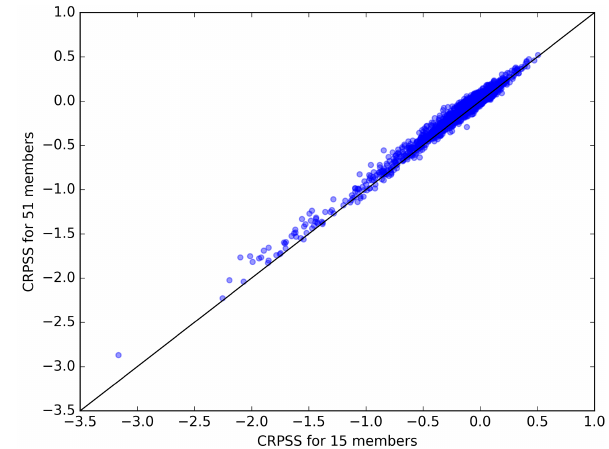
Figure 6. CRPSS calculated for the CM-SSF against the ESP (benchmark) for hindcasts made on 1 February, May, August and November, all lead times (i.e. 1 to 7 months) and all 74 European regions. The x -axis ( y -axis) contains the CRPSS calculated from 15 (all 51) ensemble members of the